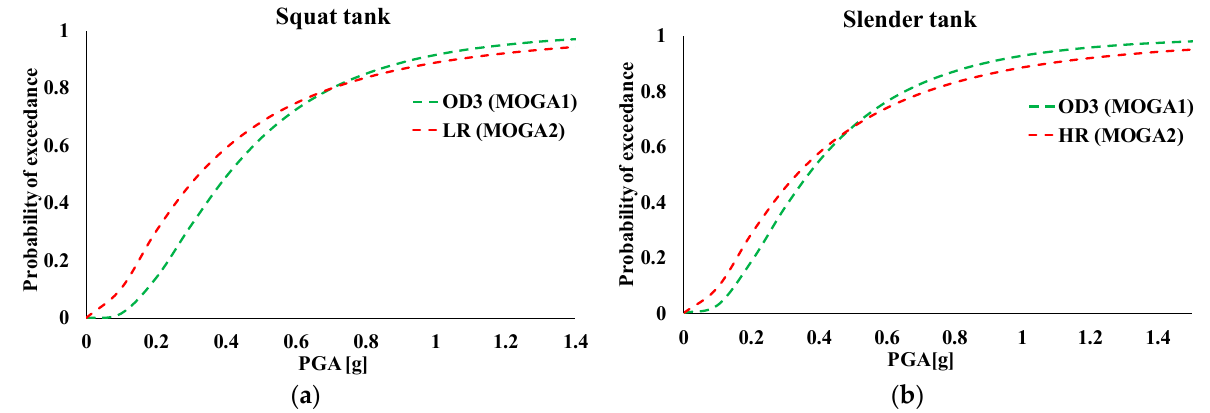
Figure 9. Comparison of MOGA1 and MOGA2 fragility curves for: ( a ) the squat and ( b ) slender tank.